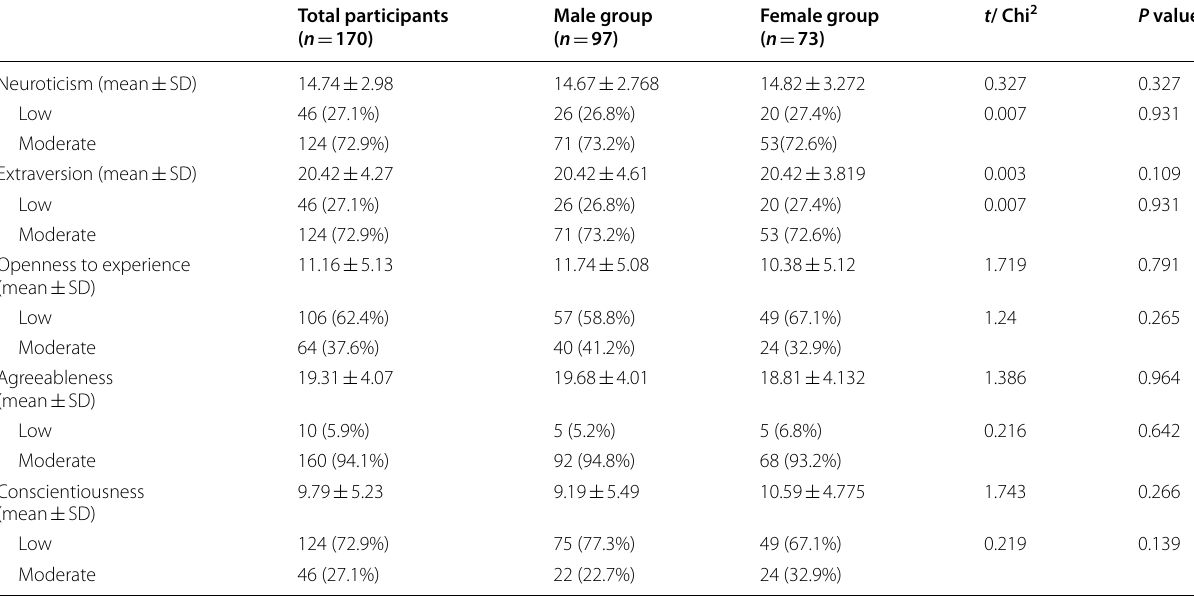
Data expressed as frequency (percentage), mean (SD). SIFFM: structured interview for the five-factor mode, P value significant if < .05